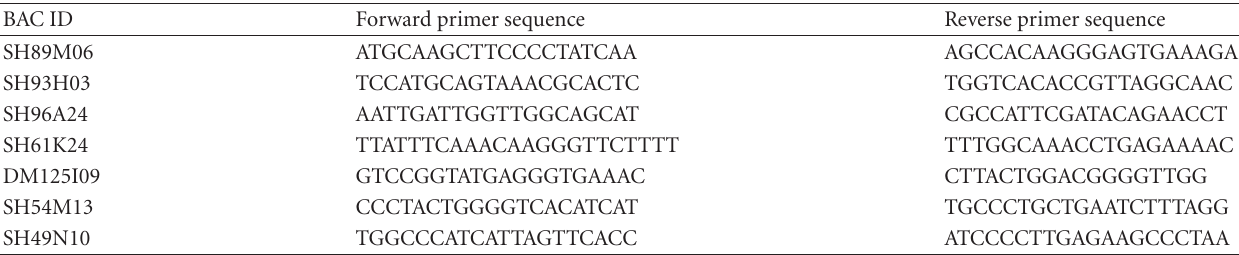
Table 3: Primers used in designing probes to screen the BAC libraries and fill the gaps of the HSY and X physical maps. BAC